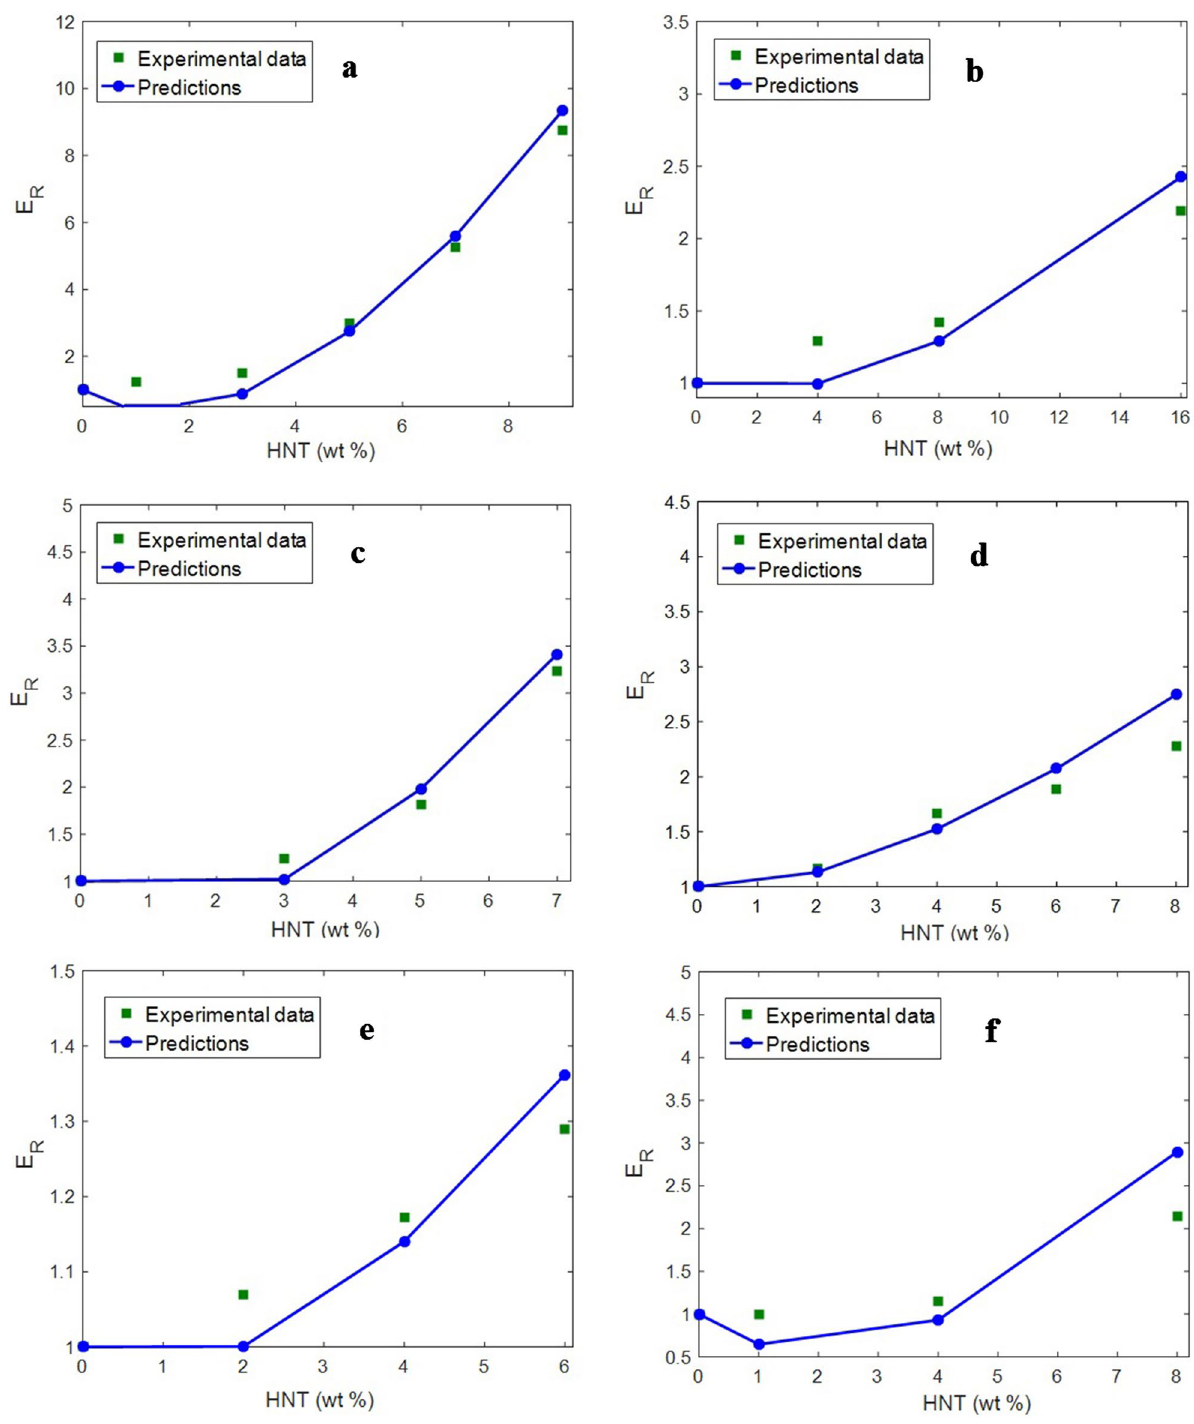
Figure 2. Experimental and theoretical (Eq. (13)) values of relative modulus of the ( a ) starch/HNT 48 , ( b ) PA12/ HNT 49 , ( c ) PCL/HNT 50 and ( d ) cellulose/HNT 51 , ( e ) PLA/HNT 17 , and ( f ) LLDPE/HNT 52 range is meaningful because it is as the nanoscale. The densest and the slimmest interphase sections are observed in cases of the PLA/HNT and PCL/HNT specimens, respectively. However, all results indicate that the samples contain interphase zones that contribute to the HNT network. HNT size and interphase depth are substituted in Eq. (5) to calculate the percolation onset. The cellulose/HNT sample exhibited the lowest percolation onset of 0.008, whereas PA12/HNT system exhibited the highest percolation onset of 0.024. These results reveal that network formation in the cellulose/HNT sample is faster than that in the PA12/HNT system. Clearly, HNT concentrations are higher than the percolation onsets, which indicate net formation in the samples.